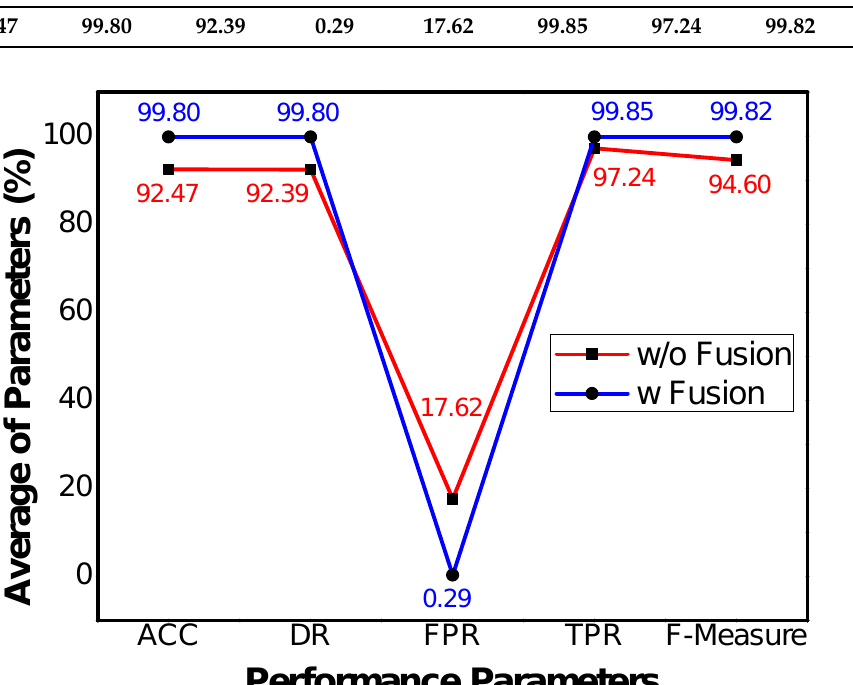
Figure 3. Average results of evaluation